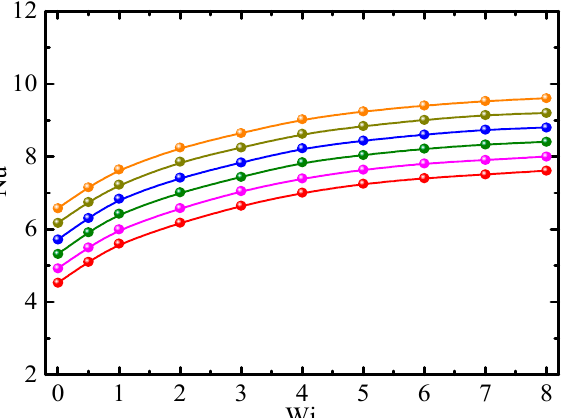
Figure 11. Nusselt number vs. Weissenberg number for different mobility parameters (Re = 2.5, Φ = 1.0%, β 0 = 0.2). — • —: α = 0; — • —: α = 0.1; — • —: α = 0.2; — • —: α = 0.3; — • —: α = 0.4; and — • —: α = 0.5.